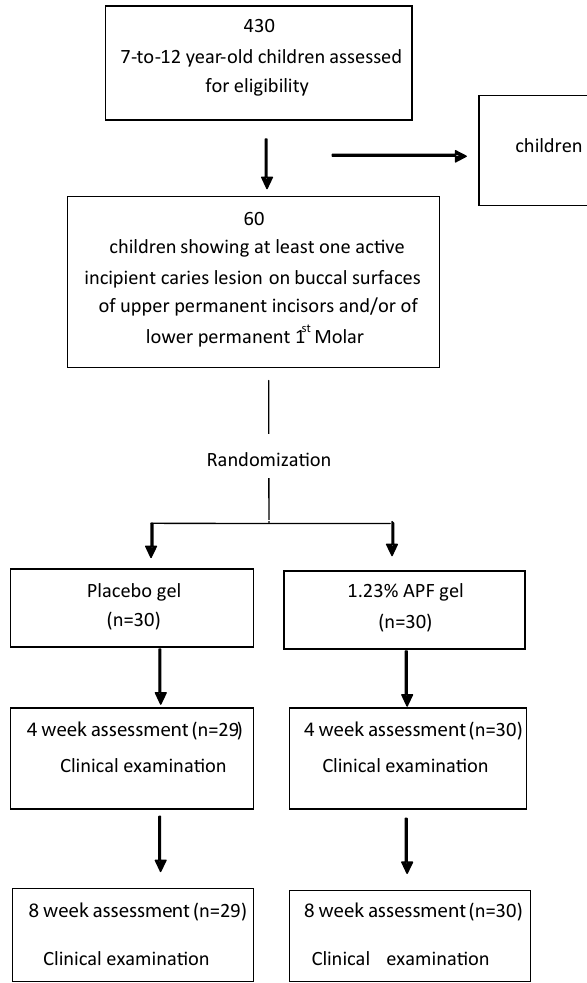
Figure 1 - Flowchart of the clinical trial.